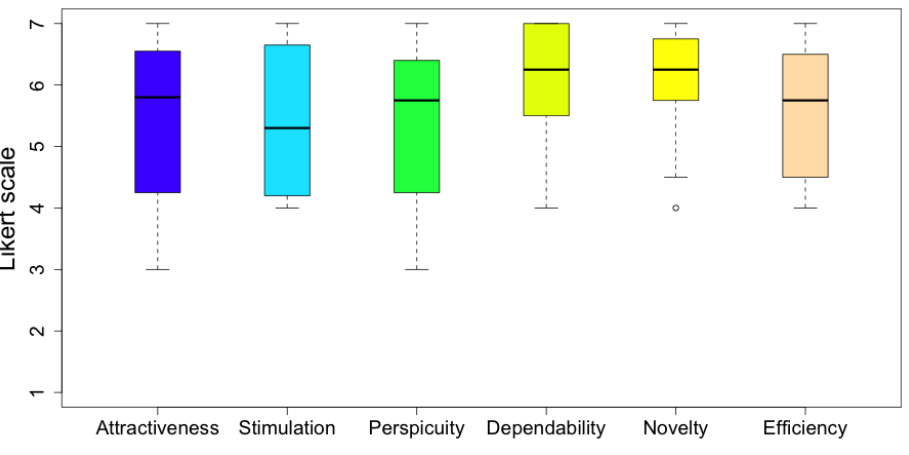
Figure 13. User eXperience (UX)